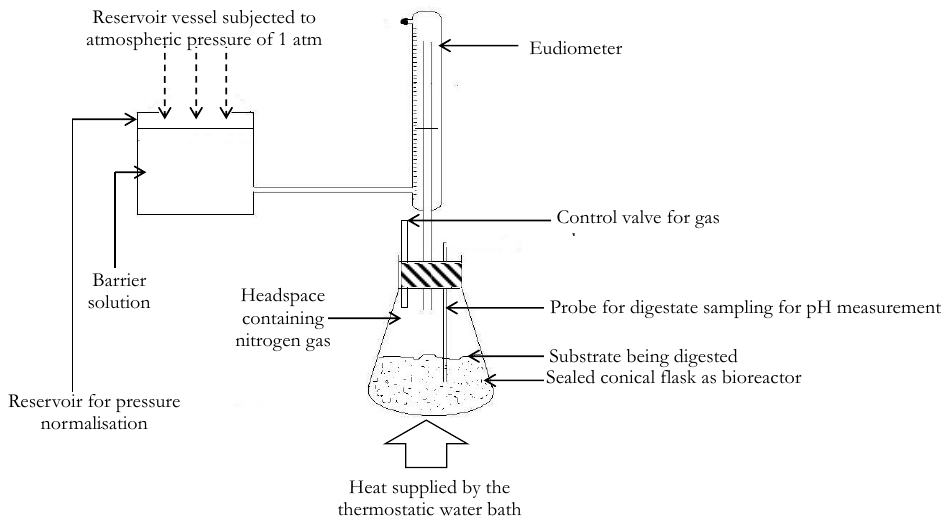
Figure 2. Labeled schematic representation of the experimental set-up for assessing the co-digestion of substrate mixtures of VS WHDS to VS SY mass ratios of 1:0, 4:1, 3:2, 2:3, 1:4 and 0:1.